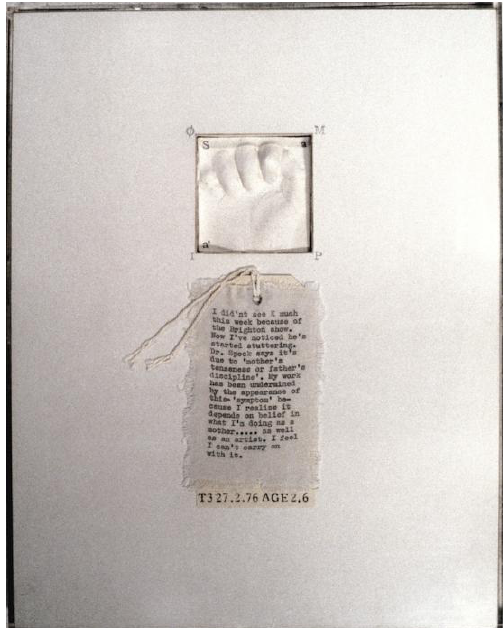
Figure 5: Mary Kelly Post-Partum Document, Documentation III, Analysed Utterances Markings and Diary-perspective Schema, 1975, (detail, 1 of 10)